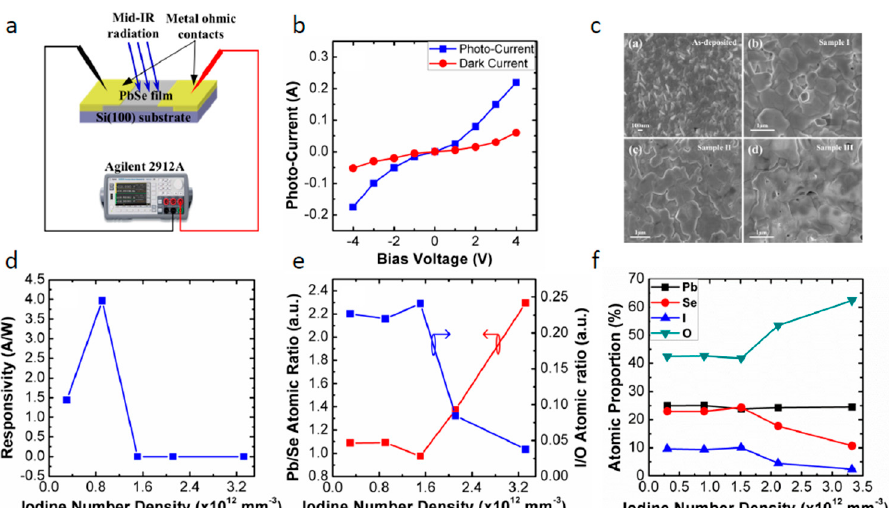
Figure 7. ( a ) Schematic of I–V tests under mid-IR illumination, ( b ) I–V test results for iodine concentration of 9.1 × 10 11 mm − 3 , ( c ) scanning electron microscopy (SEM) morphologies for as-grown and iodized samples using different iodine concentrations, ( d ) the responsivity, ( e ) Pb/Se and I/O atomic ratios, and ( f ) the atomic proportions versus iodine concentration. Reprinted with permission from [77]. Copyright Elsevier 2016.